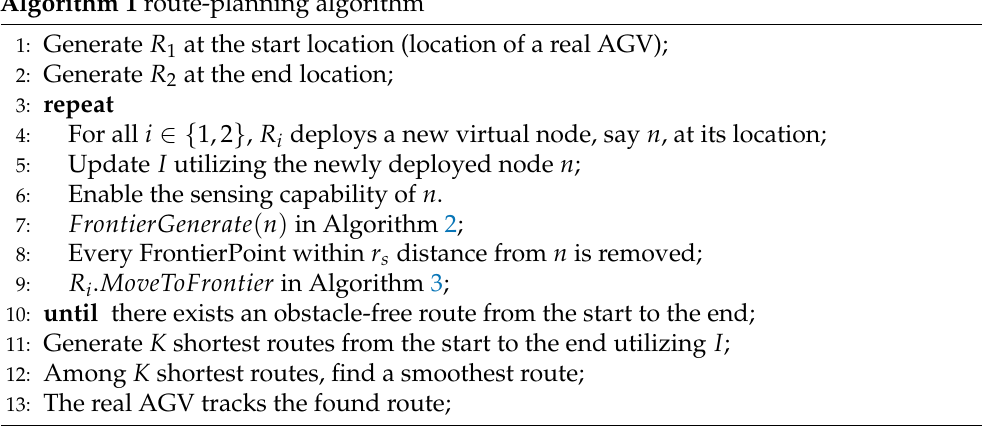
Algorithm 1 route-planning